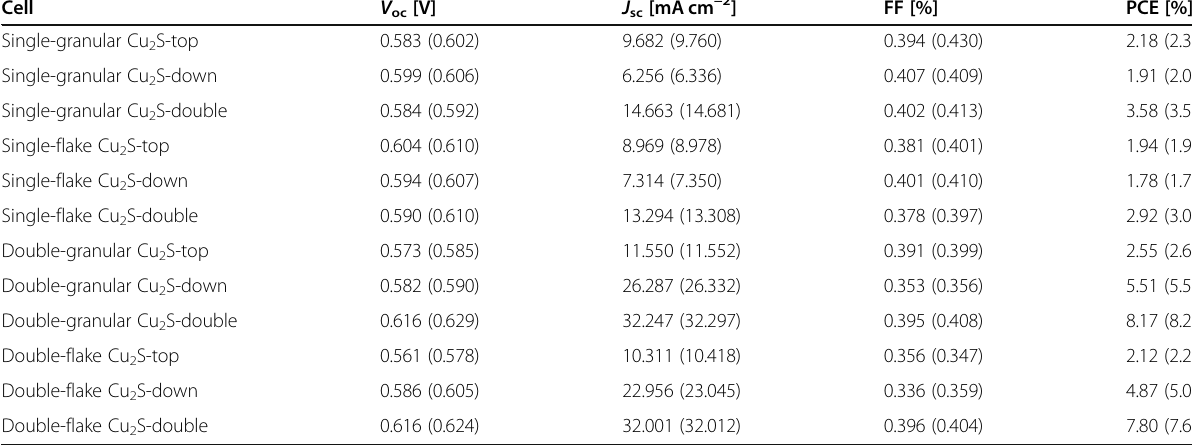
Table 1 Parameters obtained from J – V curves of various QDSSCs under different lighting conditions. The values not in brackets are the experimental average of twenty group cells, and those in brackets are champion values Cell V oc